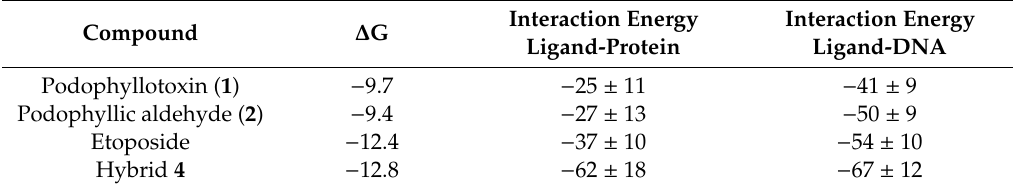
Table 2. Docking energies (kcal / mol) calculated for compound 1 , 2 , 4 and etoposide for Topo II and DNA interactions.